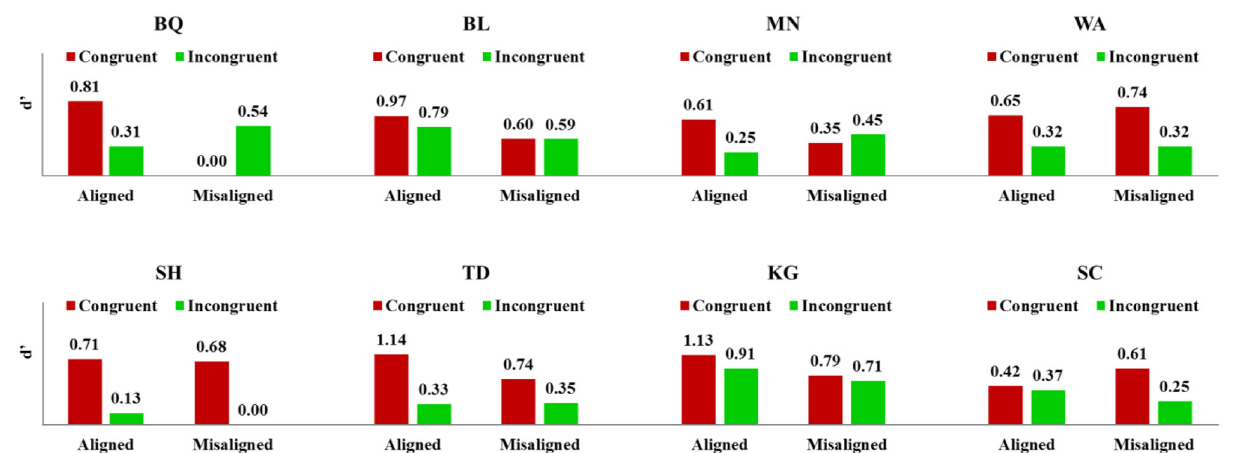
means based on all controls with the exception of the target con- trol and then assess the status of the left-out control relative to the mean and distribution of the group and this was repeated for each participant). Of the controls, 13 out of 40 do not show a Crawford significant HP result relative to the control group